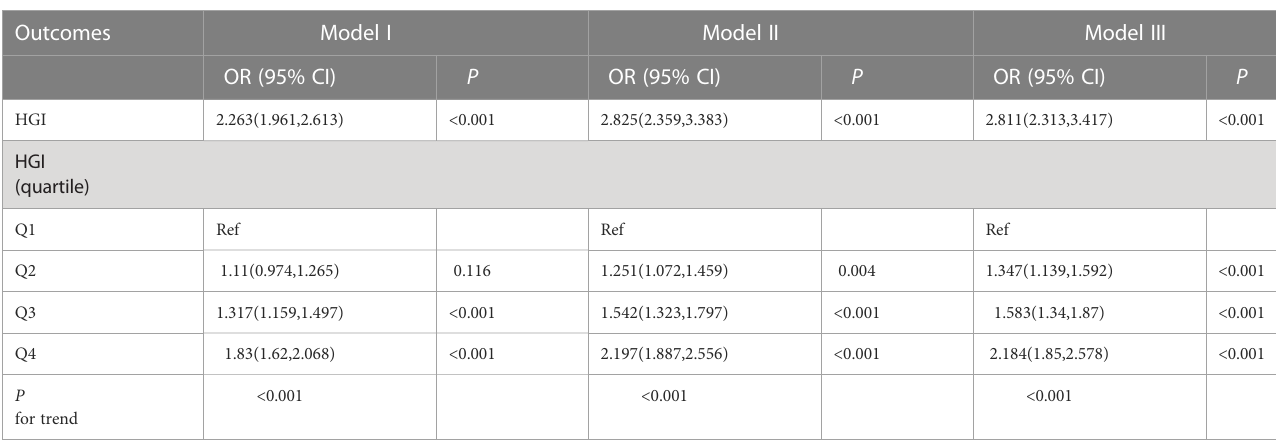
TABLE 3 Multivariate Logistic Regression Analysis of HGI for